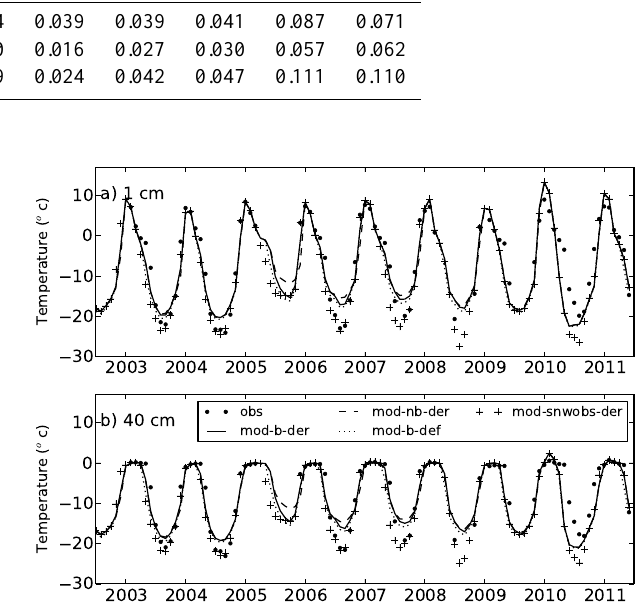
Figure 6. Comparisons of monthly average soil temperatures at 2 and 51cm depths below the rim site from simulations (mod), with and without a maximum snow thickness (b and nb), using derived and default thermal properties (der and def), with those from field measurements (obs), over the period from 2003 to 2011.